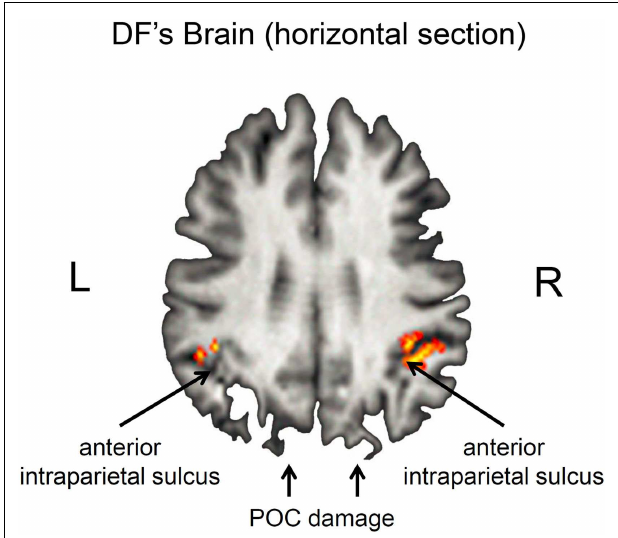
FIGURE 3 | Horizontal section through DF’s brain illustrating grasp- and reach-related activation in the anterior intraparietal sulcus (aIPS) . Grasp-specific activation is largely restricted to the right hemisphere. Note that these regions are activated despite the presence of bilateral damage to the parieto-occipital cortex (POC). Unlike healthy controls, there was little or no activation associated with reaching in the POC